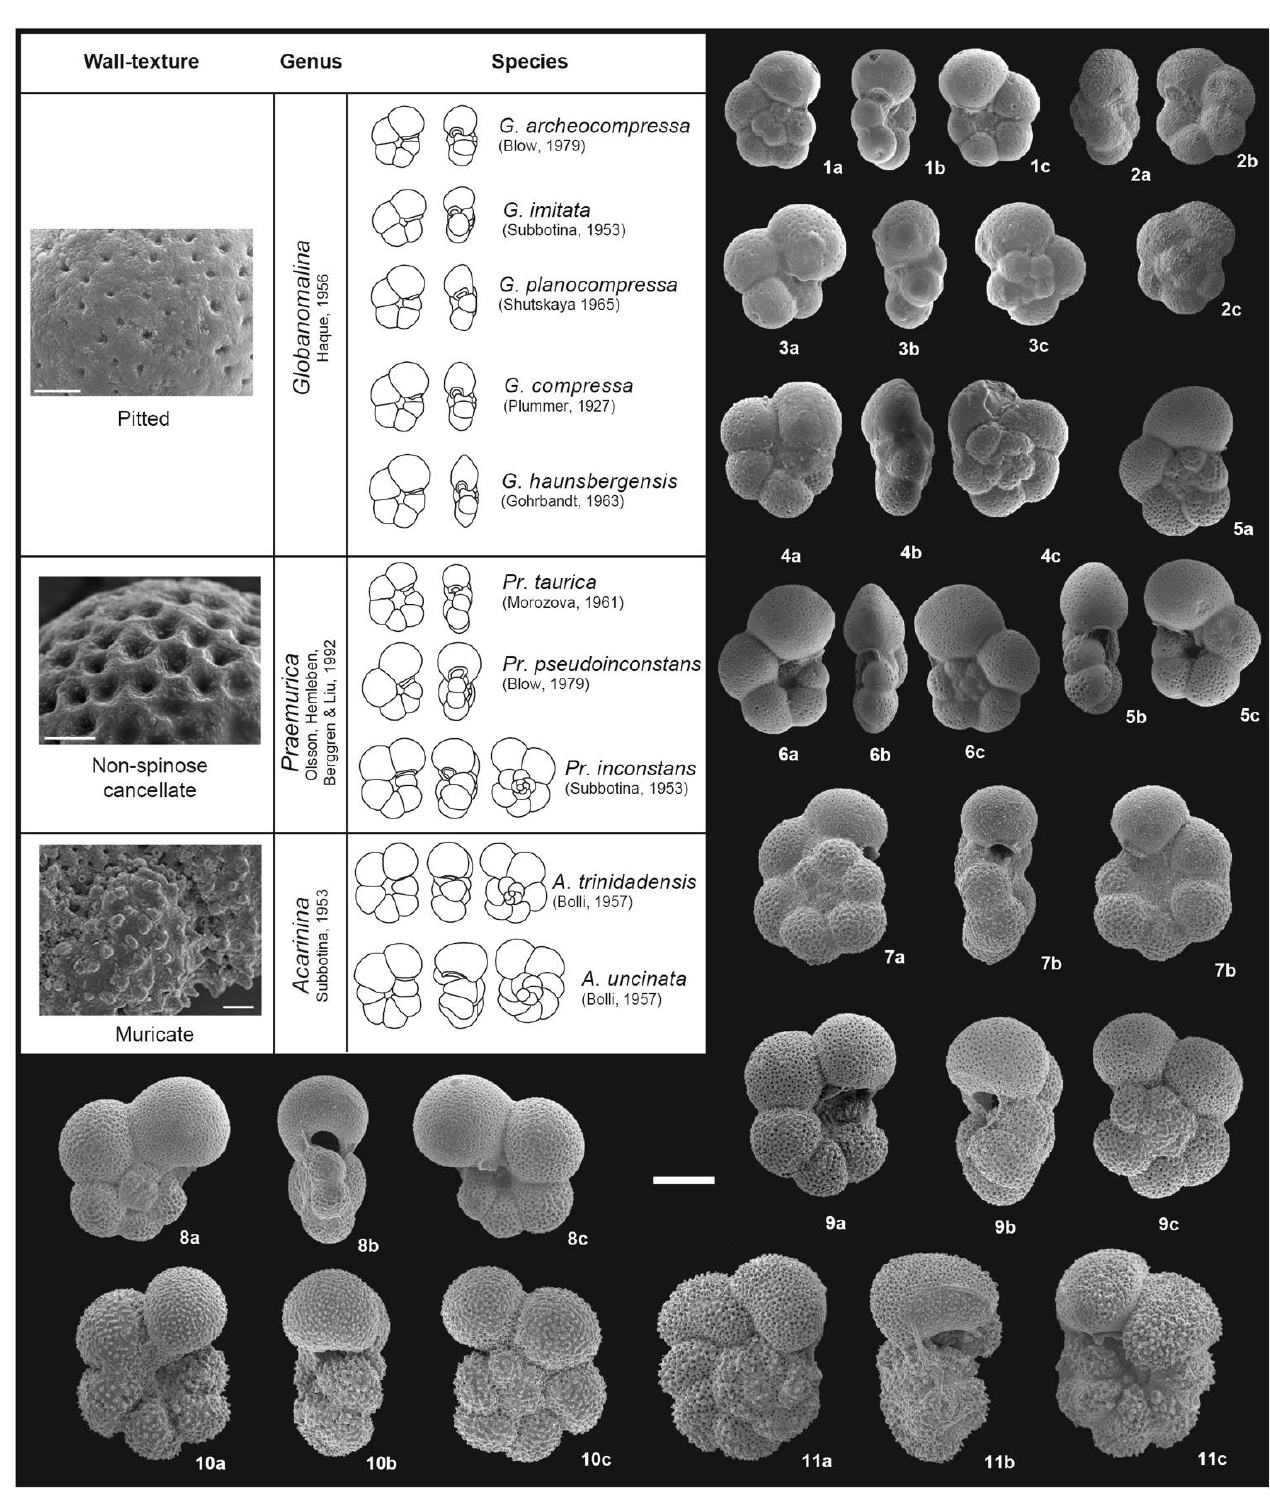
Figure A5. Early Danian species of Globanomalina and Praemurica . For taxonomic comparisons, the middle Danian species Globanomalina haunsbergensis , Acarinina trinidadensis and A. uncinata are also included. 1-2. Globanomalina archeocompressa ; 3. Gl. imitata ; 4. Gl. planocompressa ; 5. Gl. compressa ; 6. Gl. haunsbergensis ; 7. Praemurica taurica ; 8. Pr. pseudoinconstans ; 9. Pr. inconstans ; 10. Acarinina trinidadensis ; 11. A. uncinata . See main diagnostic characters of these species and genera in Supplementary Text S1. Specimens are from El Kef (1–4), Sidi Nasseur (5,6), and DSDP Site 305 (7–11). Scale bar = 100 m.